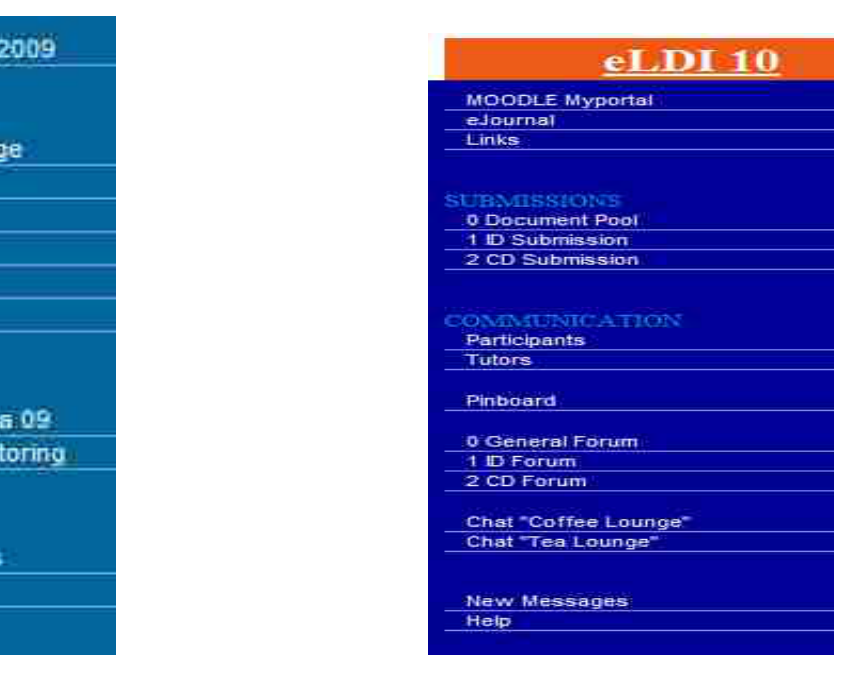
Figure 3: Communication Tools of Tutors and